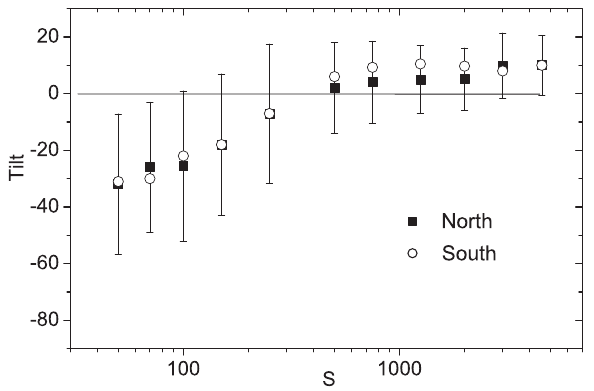
Figure 11: Tilt (deg) of bipoles as a function of their area, 𝑆 in MSH as computed by Tlatov et al. (2010) for bipoles in the – 30 (cid:176) latitude range identified in SOHO/MDI data during 1998 – 2006. Filled squares (open circles) show an average tilt for bipoles in northern (southern) hemisphere. Error bars correspond to 1 𝜎 standard deviation. Tilts for the southern hemisphere were multiplied by –1 to allow them to be plotted over the northern hemisphere tilts. The plot shows that bipoles ≤ 300 MSH, though with a large scatter, are statistically disobeying Joy’s law. Image reproduced with permission, copyright by